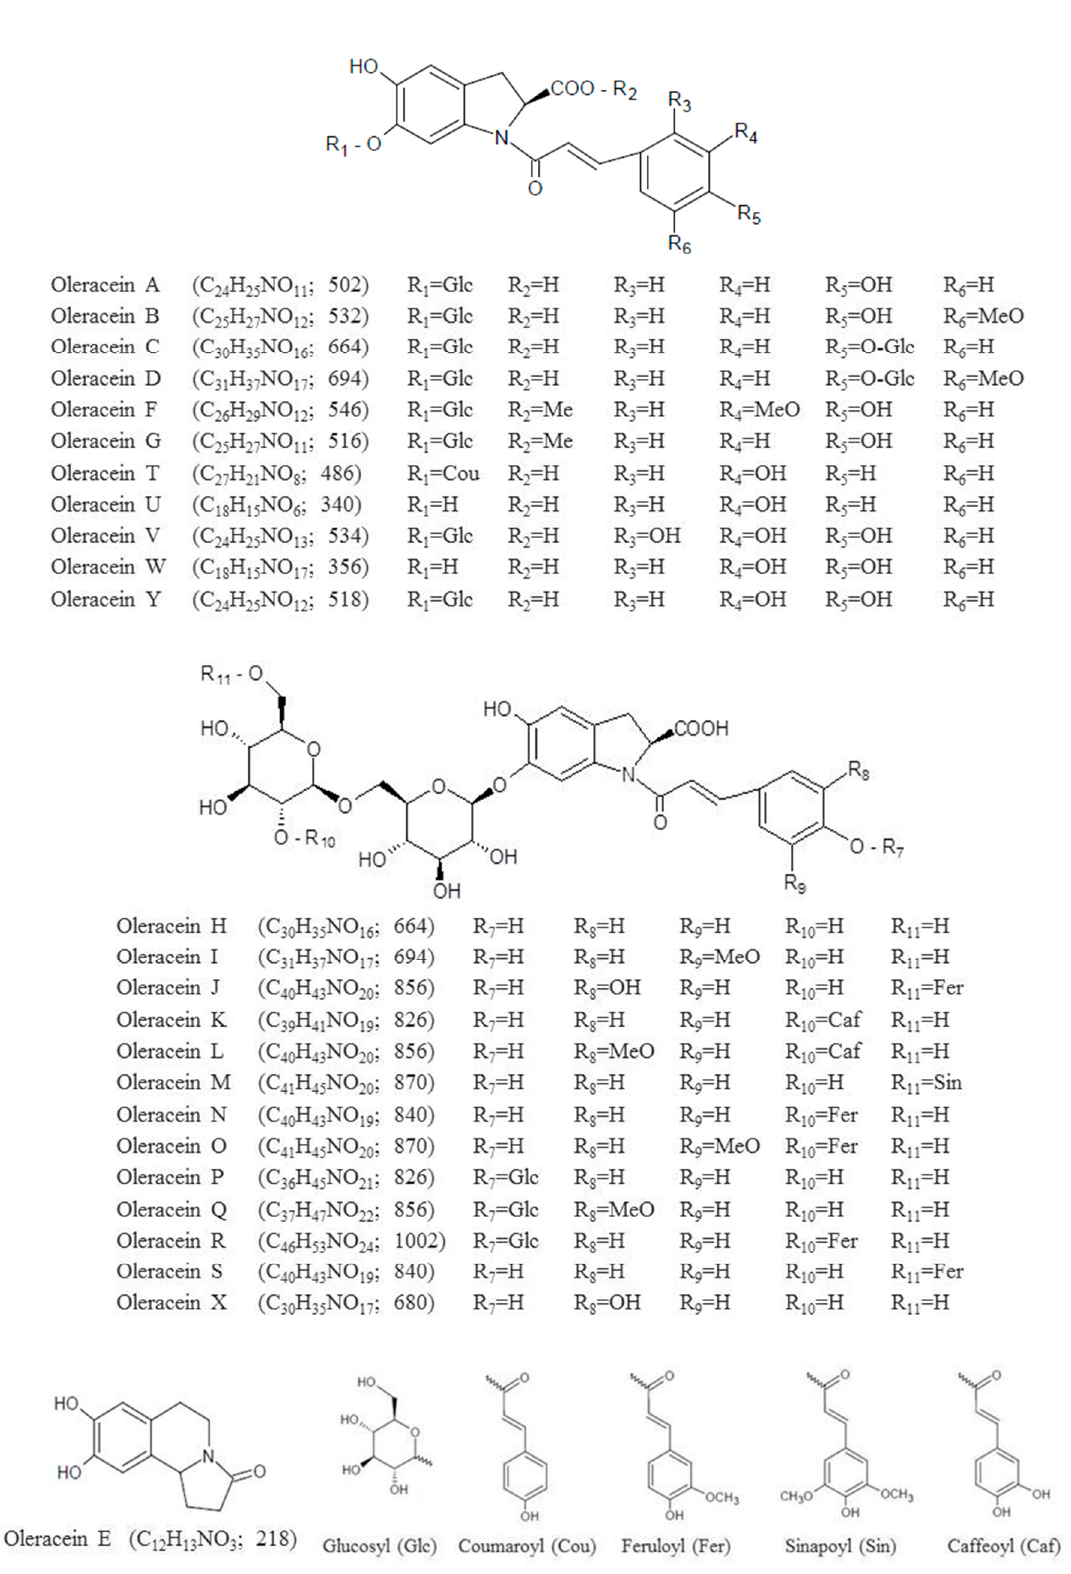
ions. They were characterized as isocitric acid and citric acid, respectively, by comparison